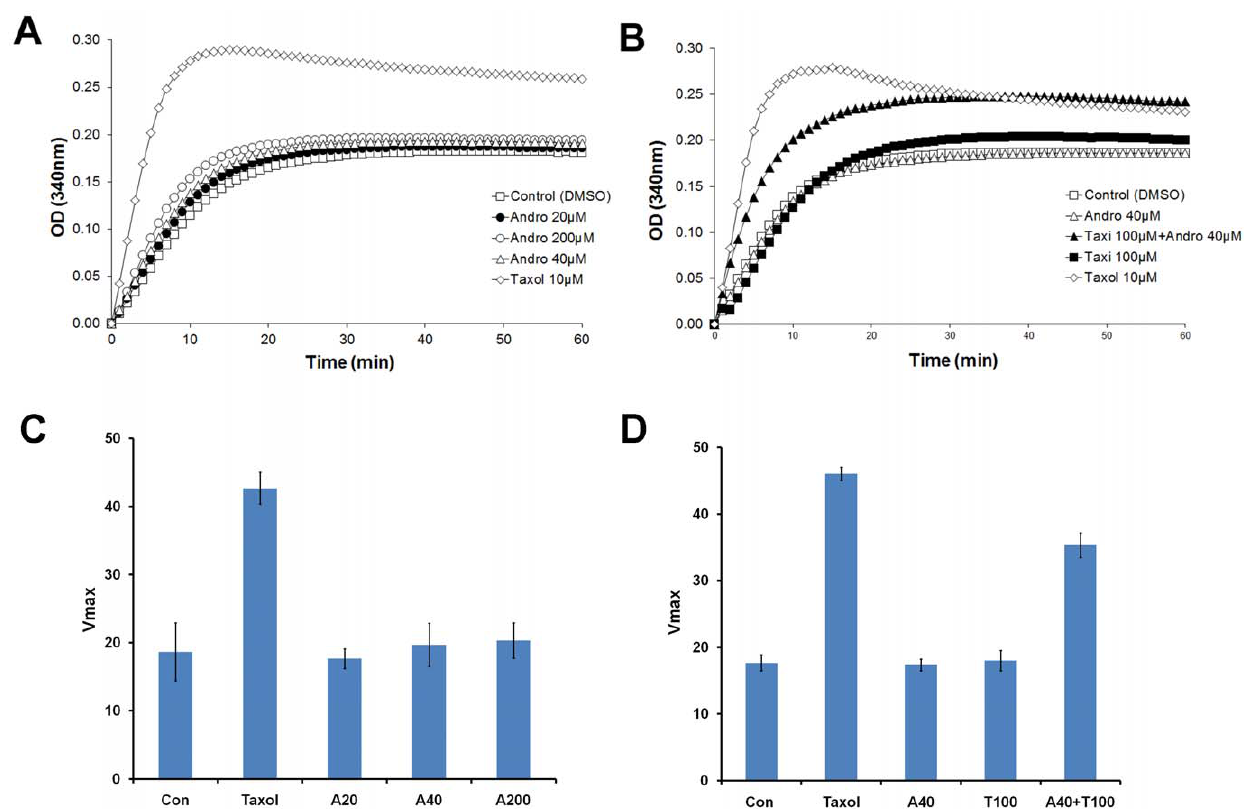
Figure 10. The combined effect of Andro and Taxi on enhancing tubulin assembly invitro . Tubulin was incubated at 37 u C in the reaction buffer in the presence of (A) 1% DMSO (vehicle control), Andro (20, 40 or 200 m M) or 10 m M of Taxol (positive control); (B) 1% DMSO; 100 m M Taxi; 40 m M Andro; 40 m M Andro + 100 m M Taxi; or 10 m M Taxol. Tubulin polymerization was monitored by measuring the optical density at 340 nm for 60 min. Data are representative of three independent experiments. (C and D) The rate of increase in OD, Vmax, of the indicated conditions was plotted. The data represent the mean 6 s.d. from three independent experiments.